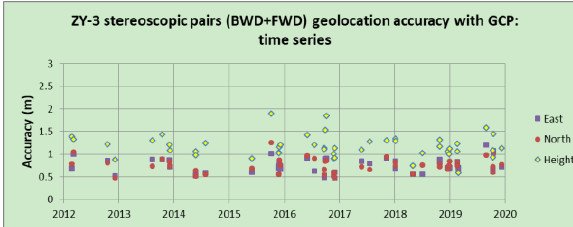
Figure 15. ZY-3 stereoscopic pairs (BWD+FWD) geolocation accuracy with